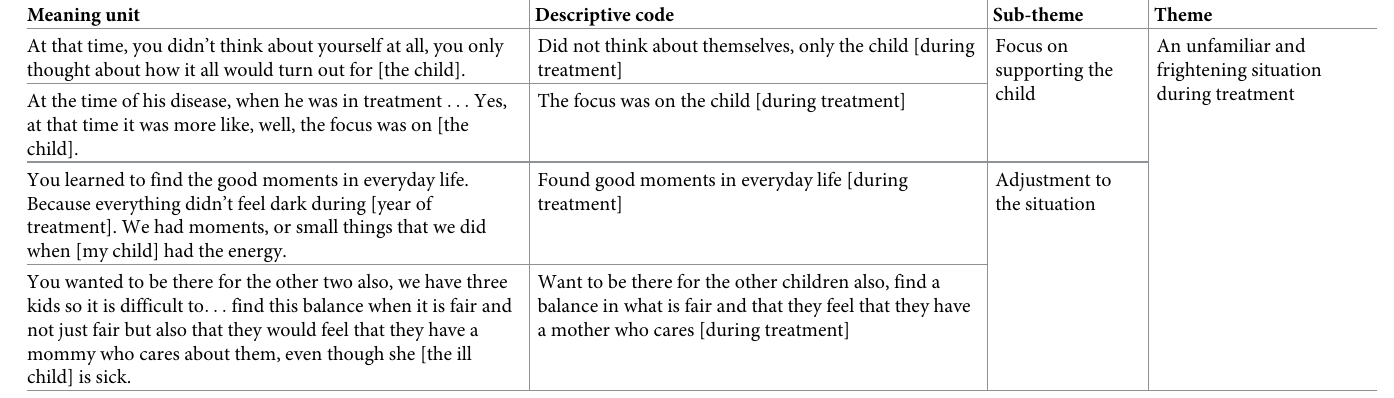
Table 1. Examples of the analytic